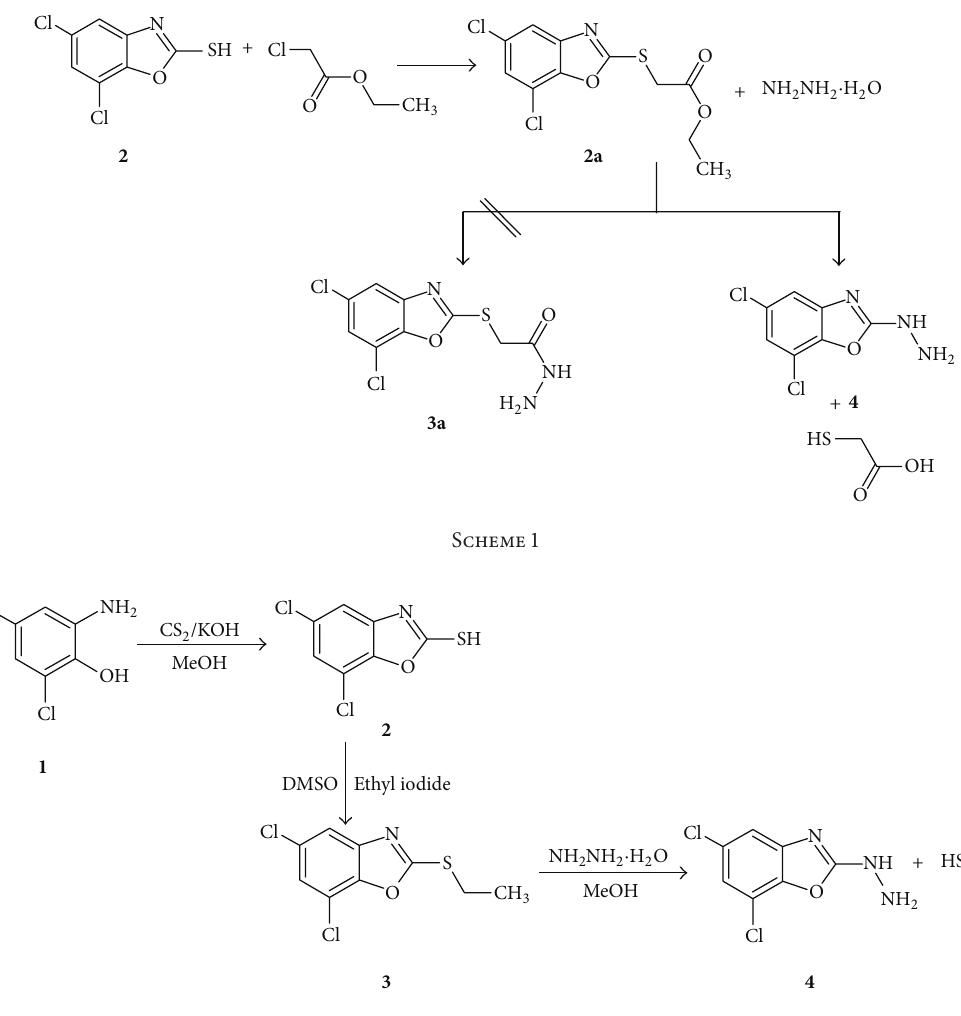
Scheme 2: Synthetic route for compound 4 .